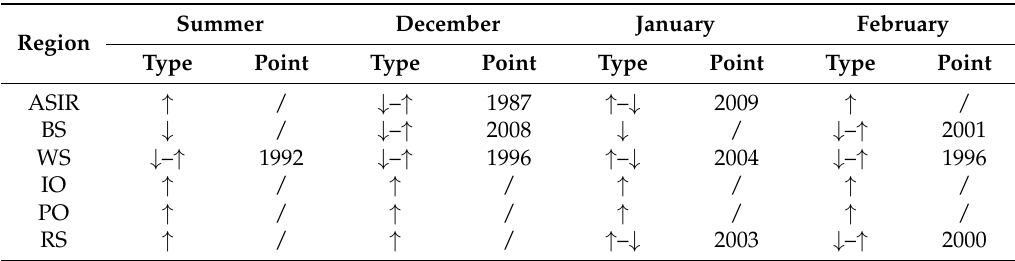
Figure 7. Slope values of the SAL (% per year) during summer ( a ), December ( b ), January ( c ), and February ( d ) are estimated through a 5-year slope test method; the ordinate presents the slope value. The black dotted lines represent the horizontal zero line. Table 7. Change trend types and transition points of the SAL for the ASIR and the five longitudinal sectors during the summer and the 3 months.